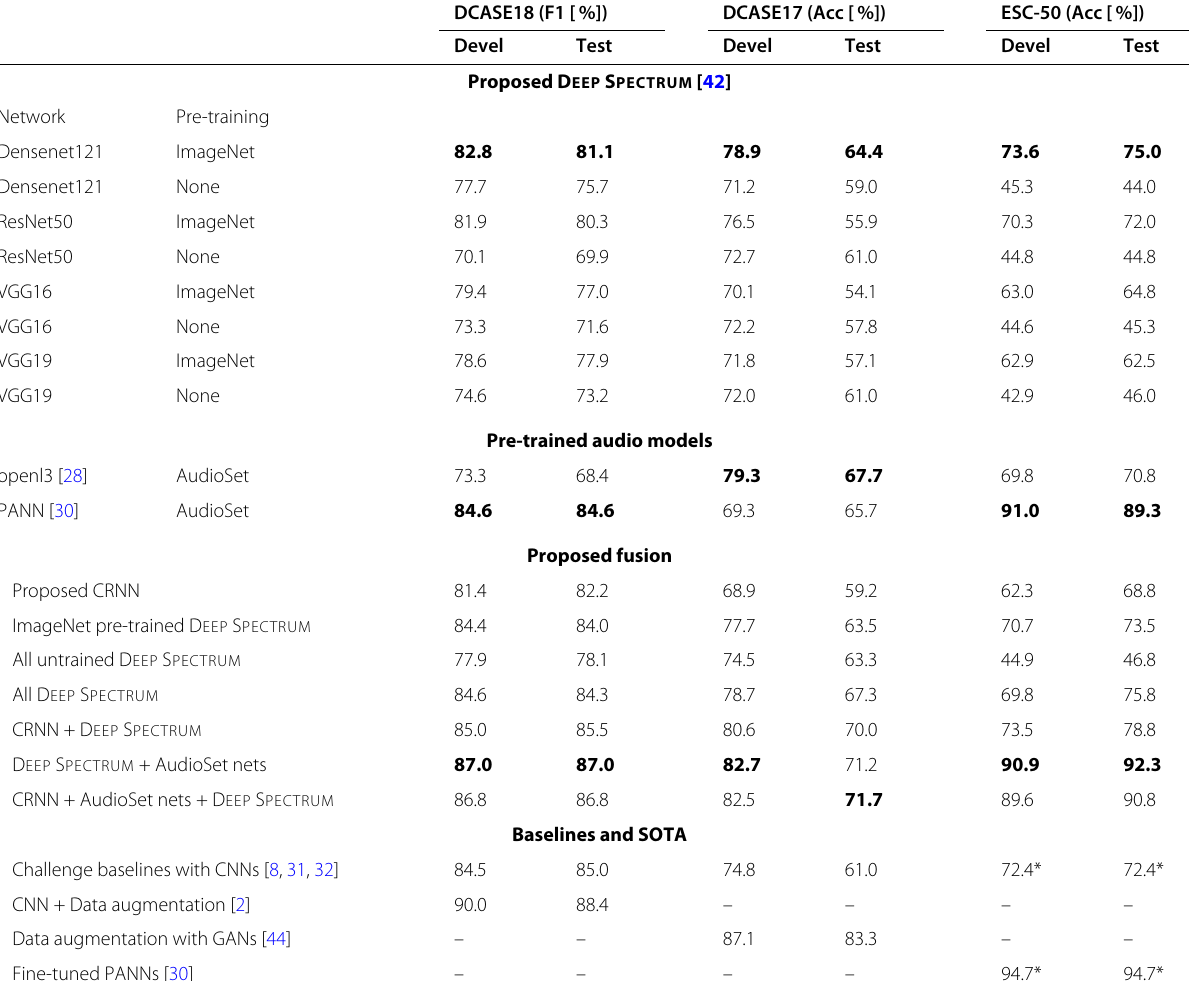
Table 3 Results of D EEP S PECTRUM , pre-trained audio models, CRNN and their fusion on DCASE 2018, task 5, DCASE 2017, task 1 [31] and